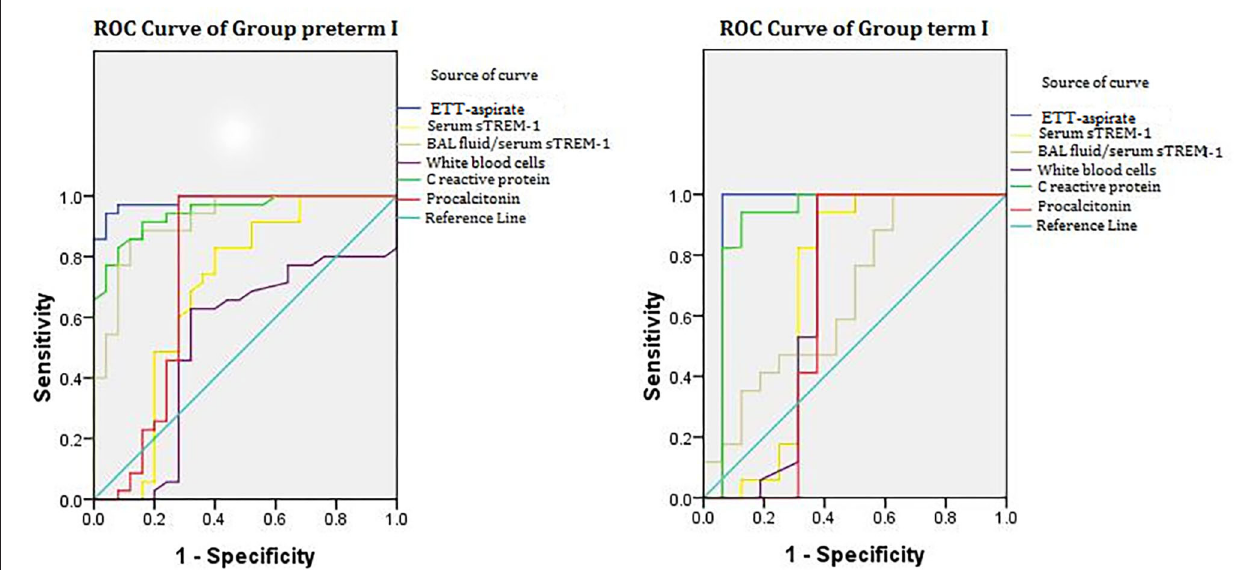
FIGURE 3 | ROC curve of groups ptP + E– and ftP + E–. ROC analysis performed in groups ptP + E– (17 cases) and ftP + E– (35 cases). Groups are based on three categories: preterm (pt) or full-term (ft); NVAP (P + ); and extrapulmonary infection absent (E–). ROC, receiver operating characteristic; ETT, endotracheal tube; sTREM-1, soluble triggering receptor expressed on myeloid cells-1; NVAP, neonatal ventilator-associated pneumonia.